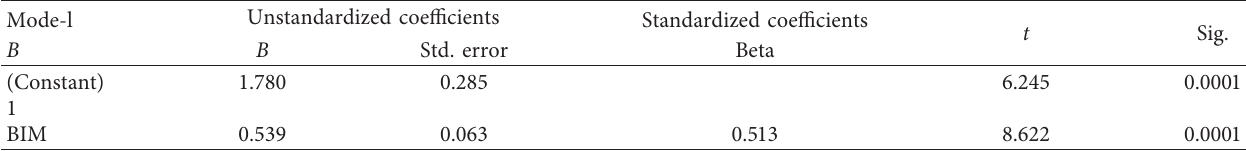
Table 6: Linear regression showing impact on planning